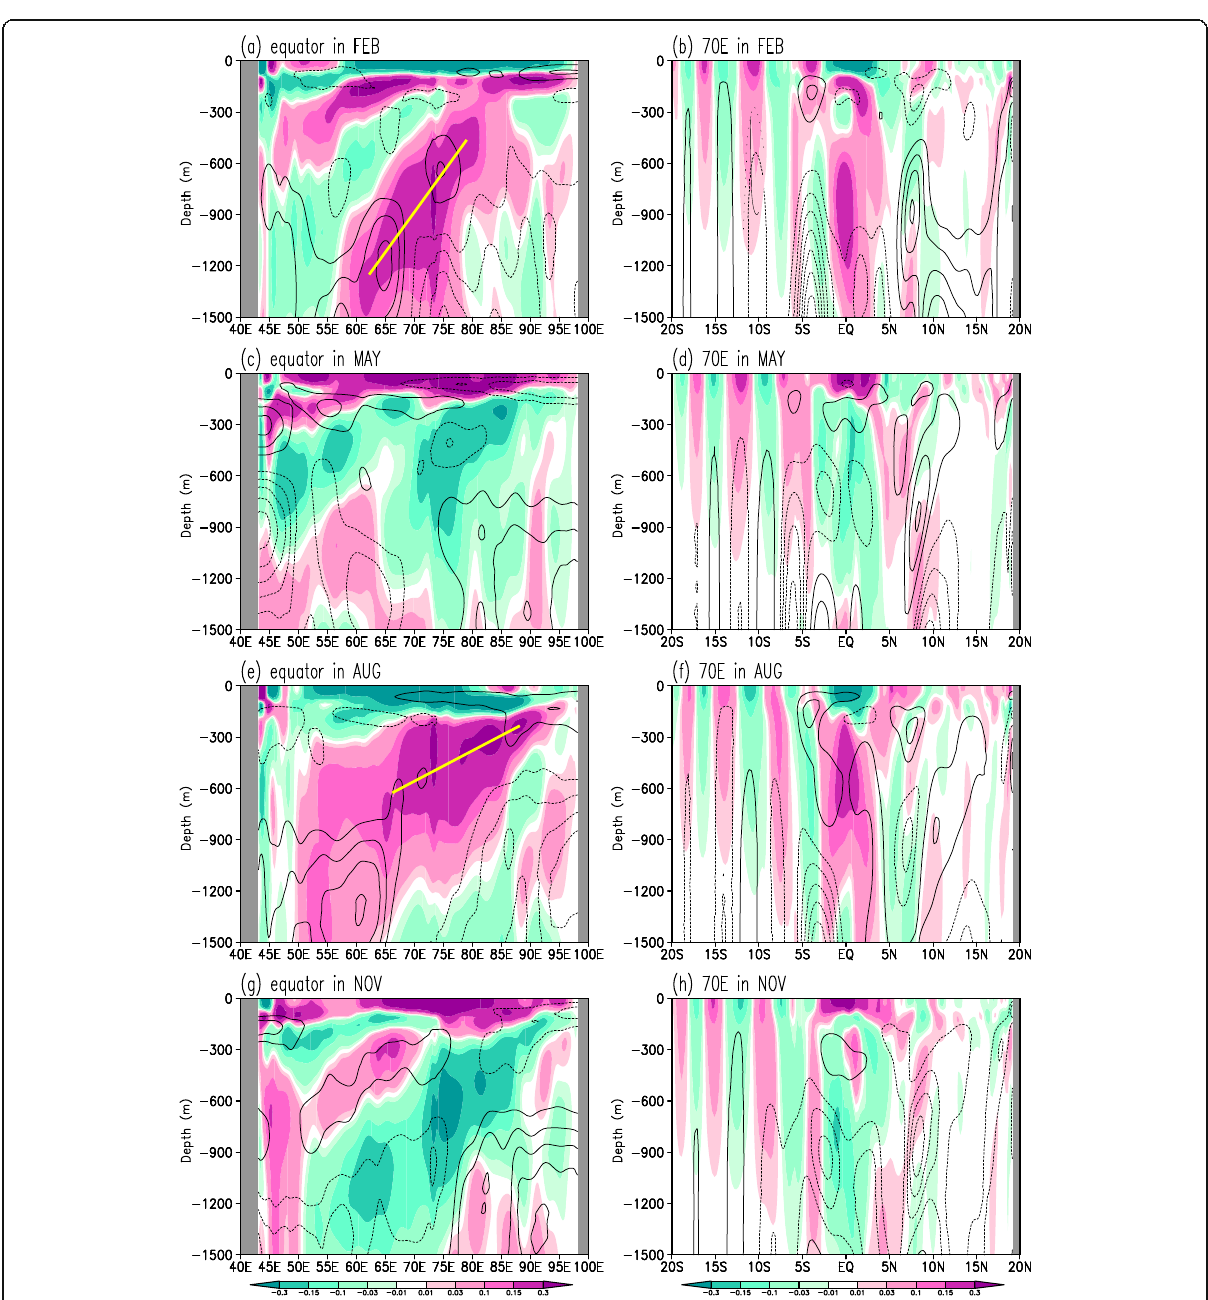
Fig. 2 The zonal component of simulated velocity (color shading with a unit of m/s) and the vertical component of simulated velocity (solid- and dotted-contours indicate positive and negative values, respectively, with an interval of 4 × 10 − 6 m/s) shown by snapshots in the middle of a , b February, c , d May, e , f August, and g , h November from “ Year 20 ” of our climatological model experiments. Zonal-vertical section at the equator (left panels) and meridional-vertical section at 70° E (right